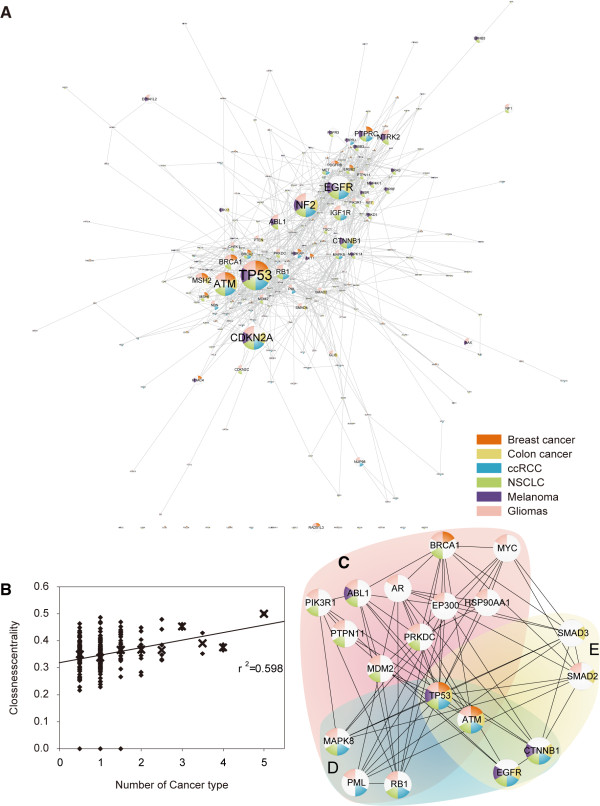
The network properties of mutated genes in core modules.(A) The network of the mutated genes in TRMs_100 is visualized using Cytoscape. Pie charts of each node marked their corresponding different cancer types and the size indicated the number of cancer types. (B) The scatter plot for the closeness vs. the number score of cancer type (diamond dot). The linear regression line was built using the medium of the closeness for each number score (x dot). The top 30 hub genes of the network (A) was mapped on gliomas (C), ccRCC (D), and colon cancer (E), respectively.